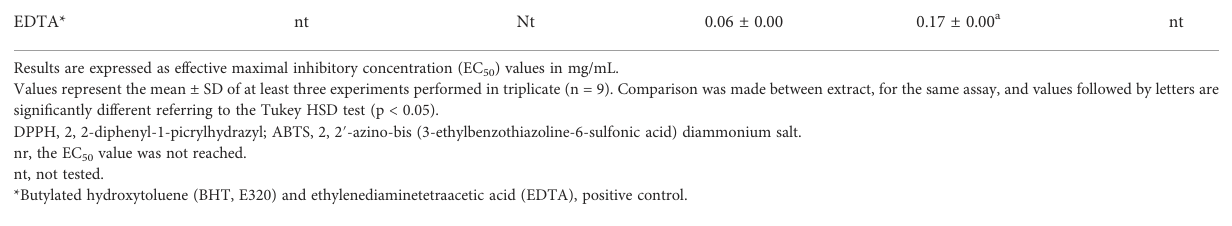
Results are expressed as effective maximal inhibitory concentration (EC 50 ) values in mg/mL. Values represent the mean ± SD of at least three experiments performed in triplicate (n = 9). Comparison was made between extract, for the same assay, and values followed by letters are signi fi cantly different referring to the Tukey HSD test (p < 0.05). DPPH, 2, 2-diphenyl-1-picrylhydrazyl; ABTS, 2, 2 ′ -azino-bis (3-ethylbenzothiazoline-6-sulfonic acid) diammonium salt. nr, the EC 50 value was not reached. nt, not